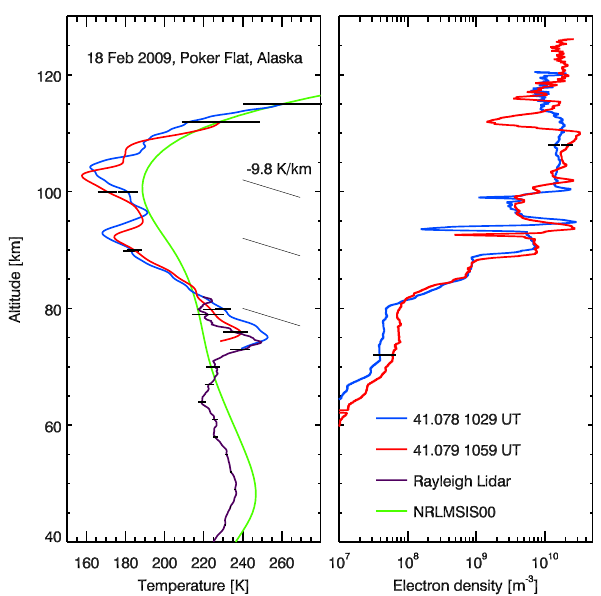
Fig. 2. Temperature profiles obtained by CONE instruments and Rayleigh lidar (left); electron density profiles obtained by nosetip probes and normalized in the E-region using incoherent scatter radar